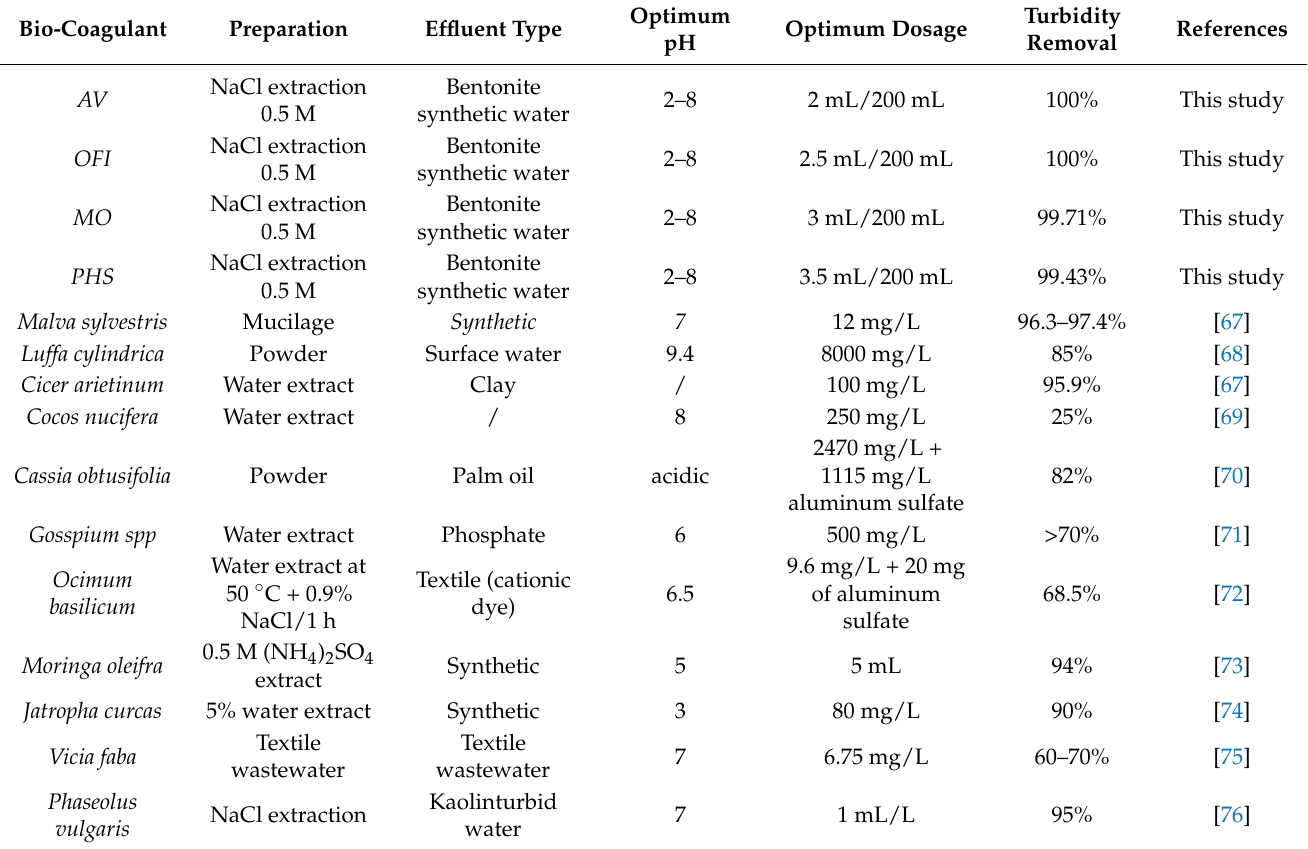
Table 2. Comparison of the studied bio-coagulants with prior